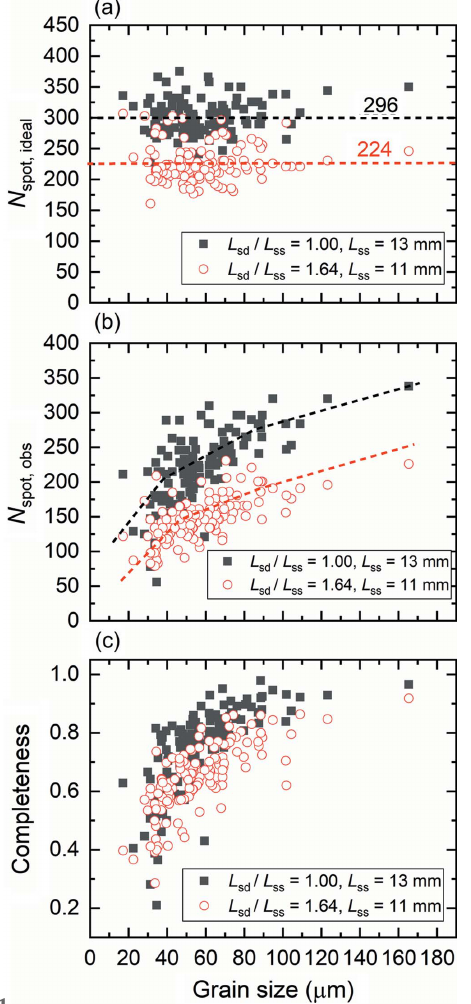
Figure 11 Number of ( a ) ideal ( N spot, ideal ) and ( b ) experimentally observed spots ( N spot, obs ) and ( c ) completeness at different L sd / L ss for a total of 181 projections as a function of grain size obtained for the first three { hkl } families of the 130 common one-to-one indexed grains located in the sample interior. Dashed lines in ( a ) are average values and in ( b ) are guides to the